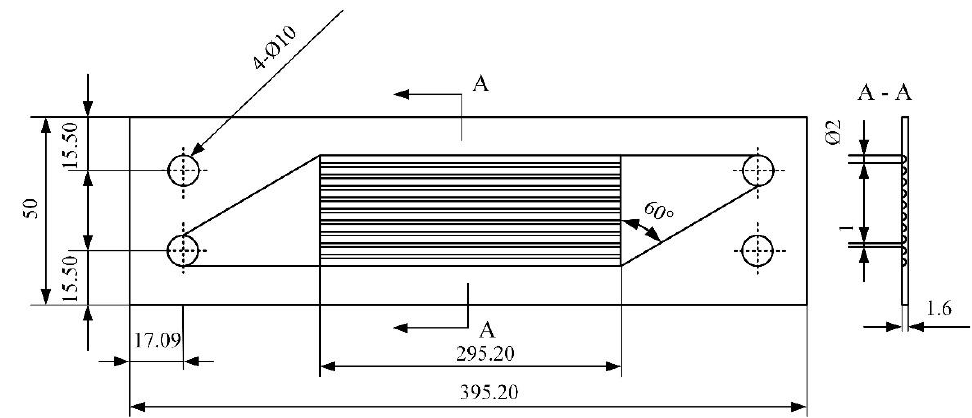
Figure 1. Structure of the PCHE.